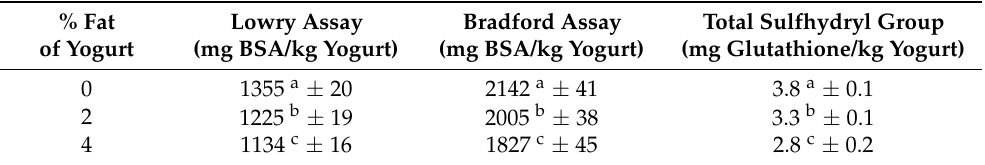
Table 10. Protein and total sulfhydryl groups content of cow yogurts with different fat content preparations obtained by pH adjustment and precipitation (pHAP) procedure 1